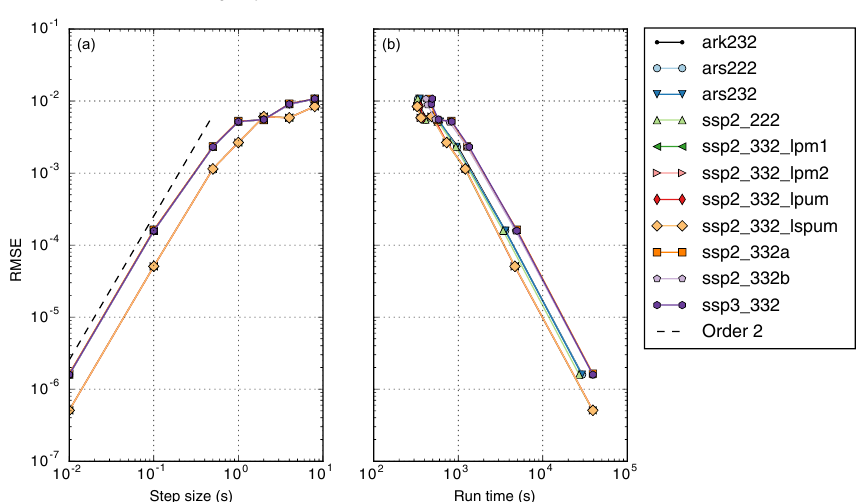
Figure 5. Accuracy (a) and efficiency (b) for the second-order methods using the Rosenbrock-like approach with the IMEX-B splitting. The ARK methods fall into two groups with similar accuracy. The dashed line represents second-order convergence. Results using multiple New- ton iterations to compute the stage solutions give nearly identical error values to the Rosenbrock-like results but increase the computational cost by at least 10%.